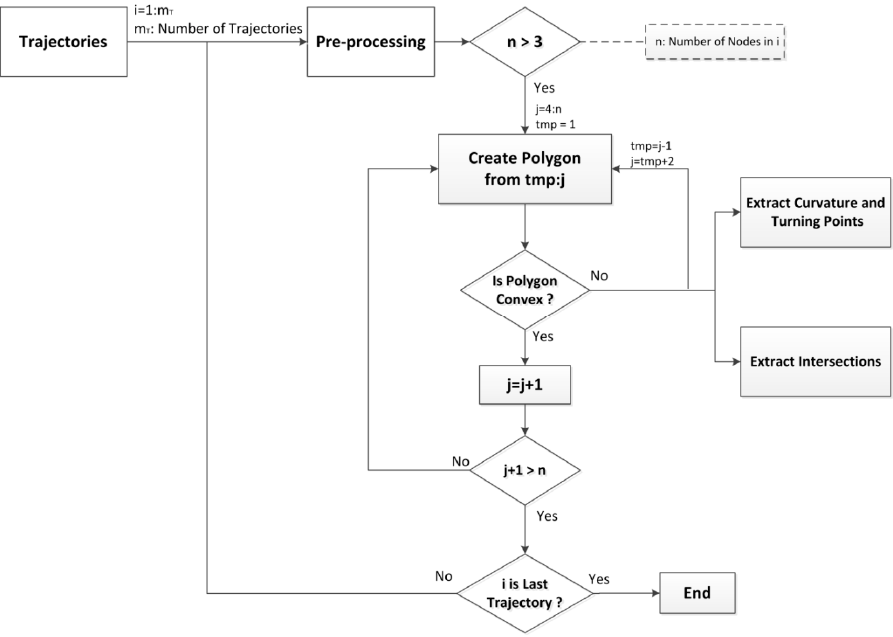
Figure 5. Methodology flowchart.